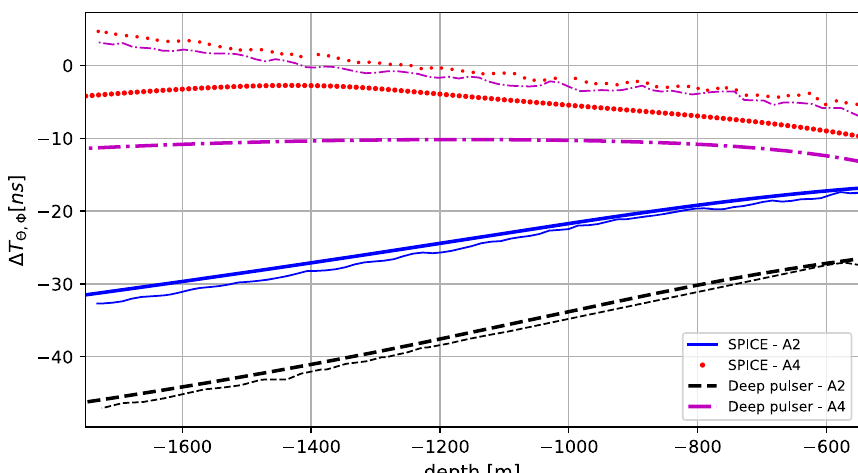
( θ , φ ) and include the antenna response (v, h). The last column shows the measured time delay between the vpol and hpol antennas. See text for details. The values indicated in bold fond represent our predictions and the normal fond values represent the predictions and measurements published in